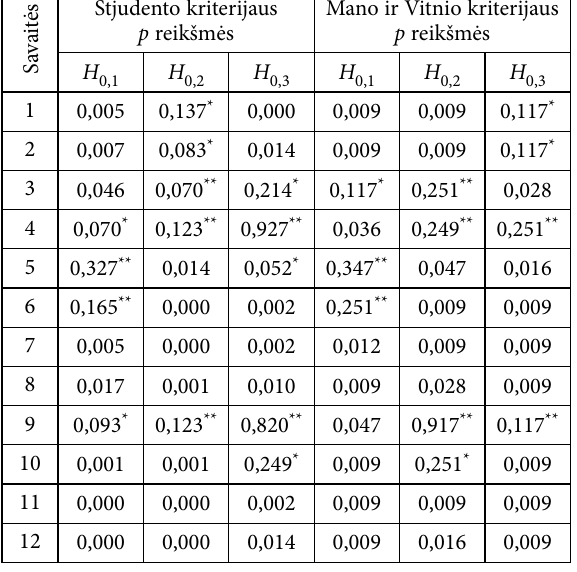
Table 3 . Criterion values of hypothesis evaluation